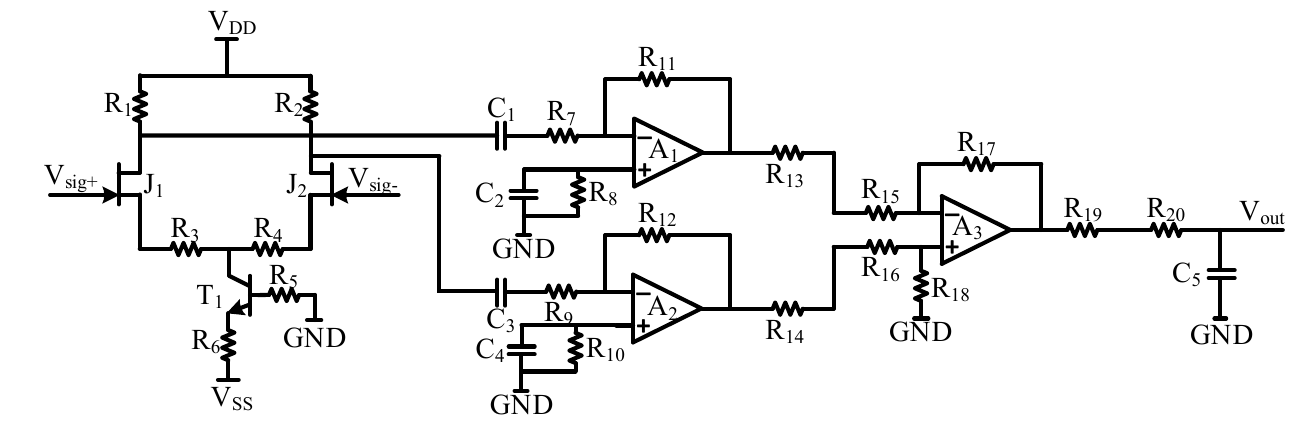
Figure 4. Schematic diagram of low-noise amplifier circuit.